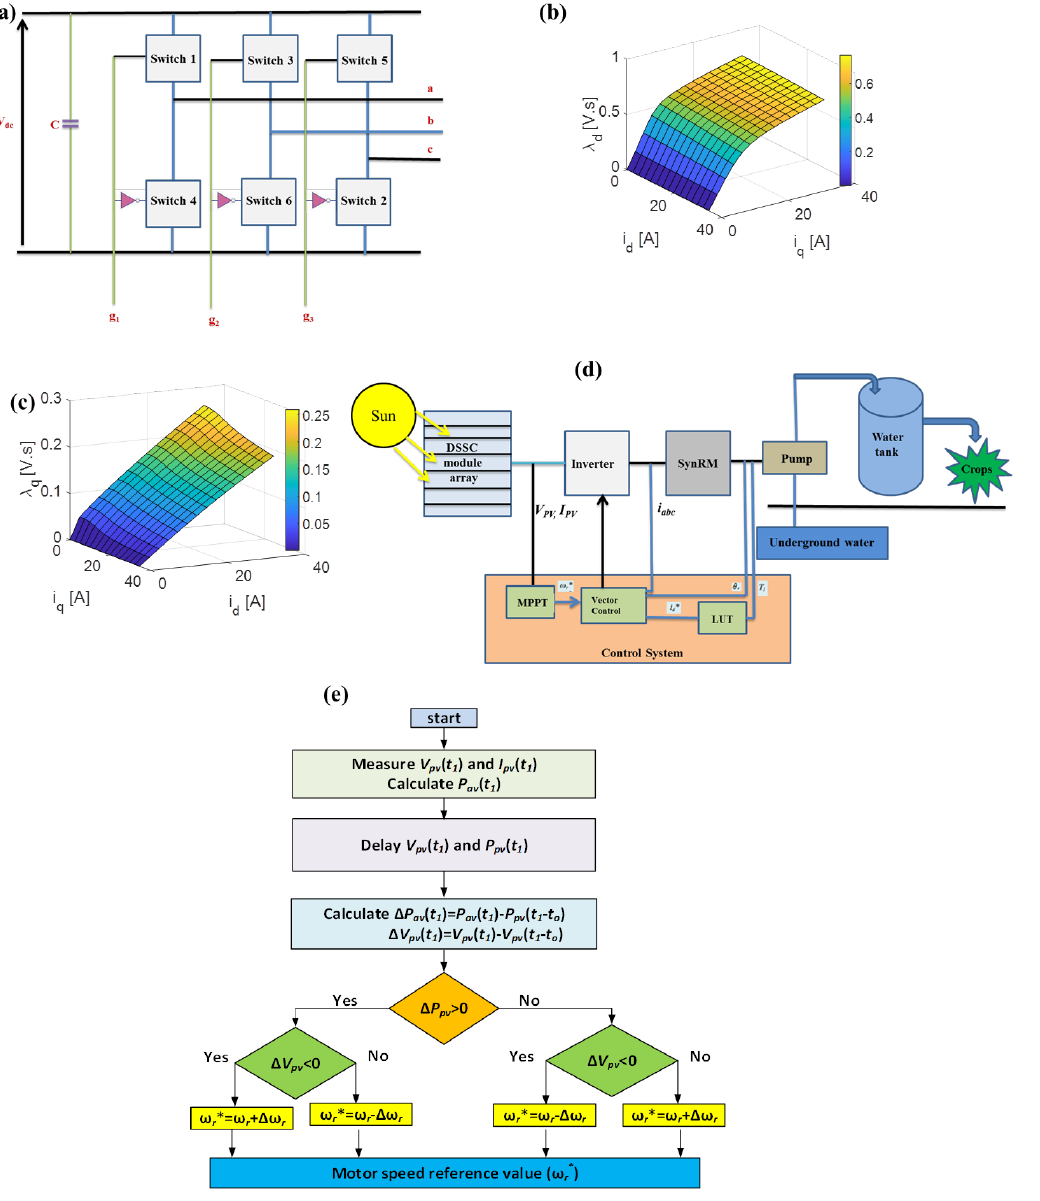
Figure 4. The voltage source inverter (VSI) model ( a ); SynRM axis flux linkage components against the current components ( b , c ); schematic diagram of the complete proposed system ( d ); the perturb- and-observe maximum power point tracing technique ( e ).